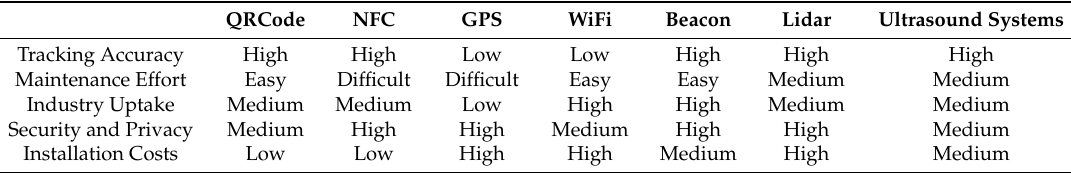
Table 1. Pros and Cons of different Indoor Location System (ILS)